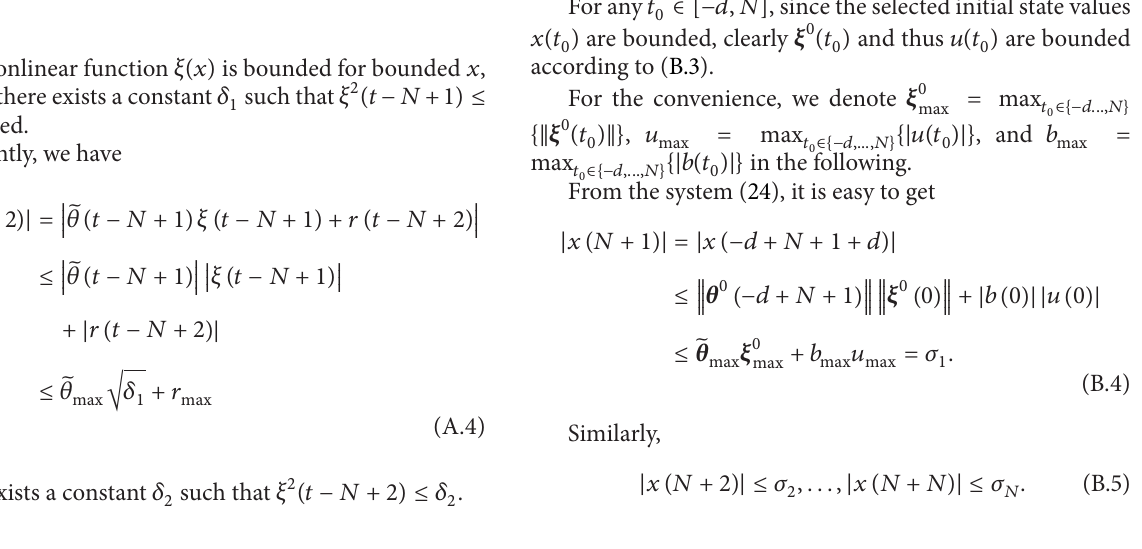
Figure 4: Finite time escape phenomenon of tracking error with standard periodic adaptive